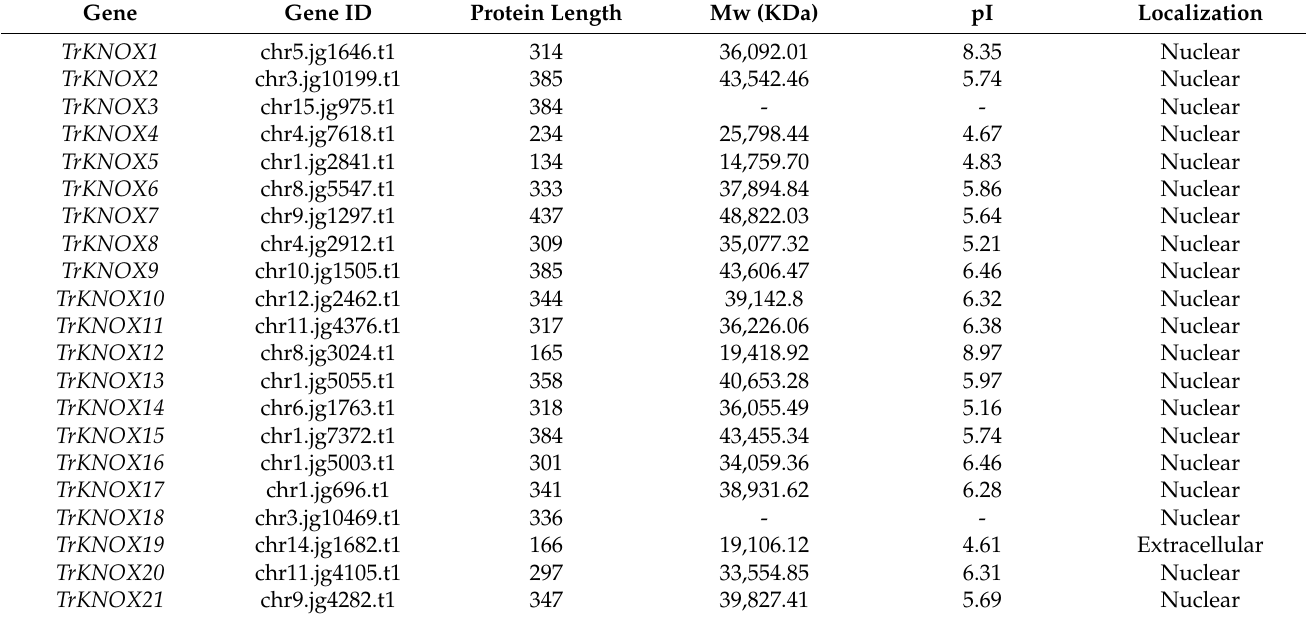
Table 1. List of the 21 TrKNOX genes identified in the